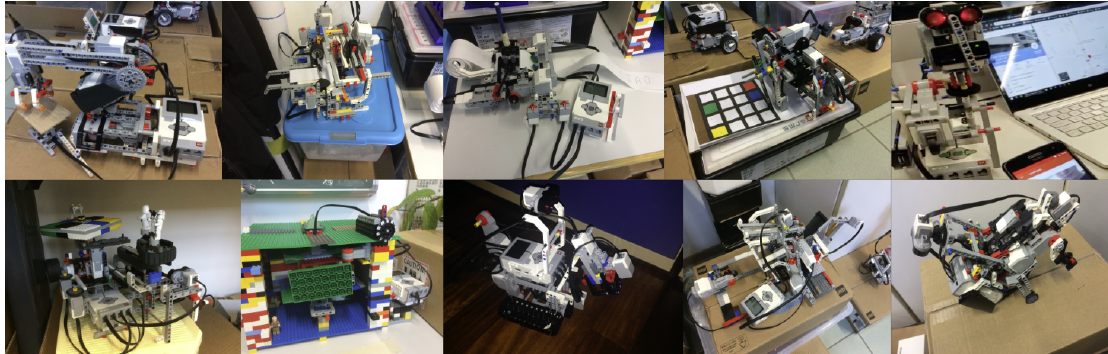
Figure 9. A selection of LEGO Mindstorms robots featured by Ca’ Foscari CS bachelor